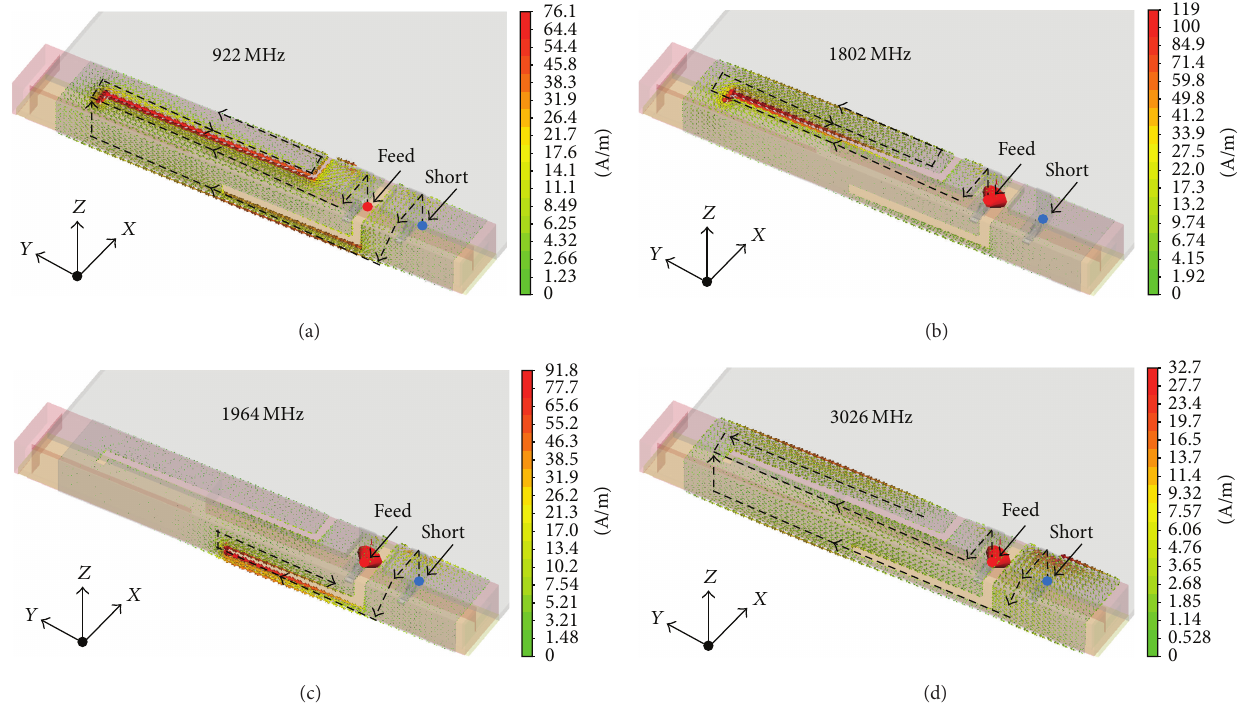
Figure 3: Simulated surface current distribution at (a) 922 MHz, (b) 1802MHz, (c) 1964 MHz, and (d) 3026 MHz.